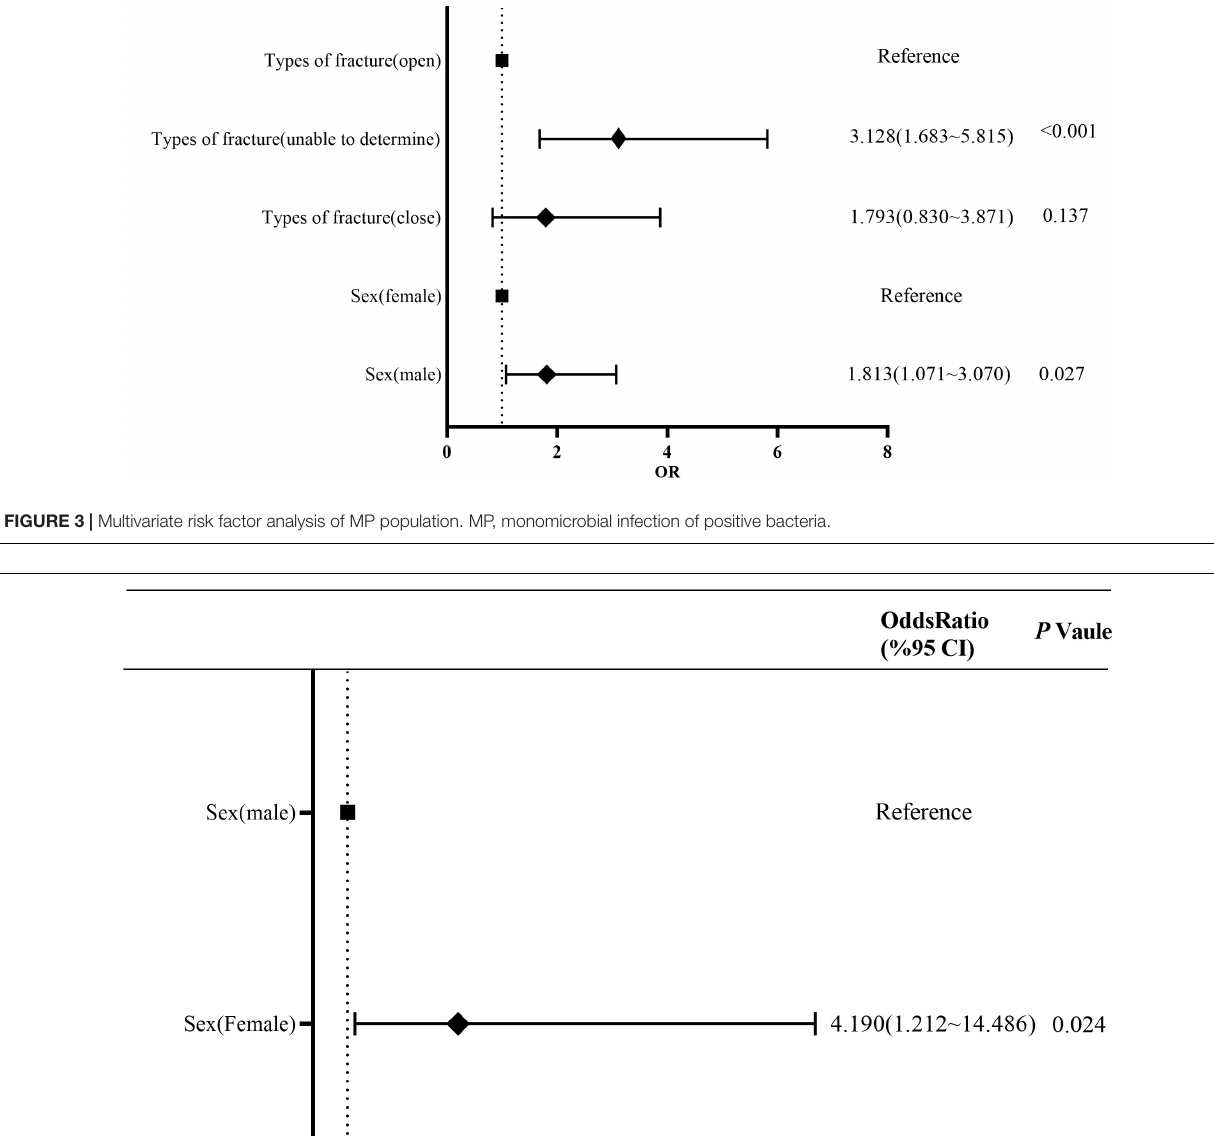
were more than 70% resistant to penicillin and erythromycin ( Figure 6 and Supplementary Table 7 ). Among Gram-negative bacteria, the drug resistance rates of A. baumannii to furadantin, aztreonam, ceftriaxone, gentamicin, and ciprofloxacin all exceeded 70%. The resistance rates of ESBL E. coli to ceftriaxone and cotrimoxazole were 90.6 and 71.9%, respectively, while the sensitivity rates to ertapenem, piperacillin-tazobactam, amikacin,